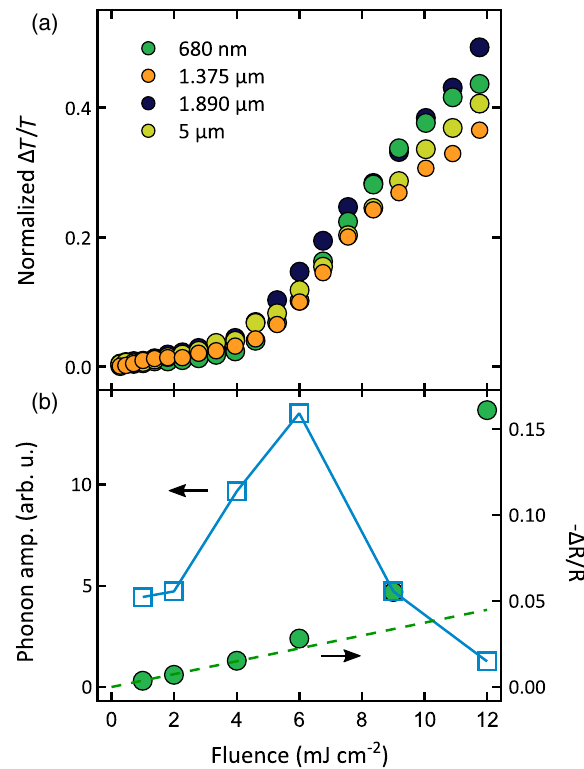
FIG. 5. (a) Normalized change in transmissivity of a free- standing VO 2 sample at 1-ps time delay measured at 100 Hz in air for different probe wavelengths. Below- and above-gap probing show the same threshold fluence, indicating that both the electronic and structural transitions occur at the same critical fluence. (b) Coherent phonon amplitude as a function of fluence measured at 690 nm from a single-crystal sample, compared with the reflectivity change measured at 1 ps, indicating the threshold measured in the visible spectral range corresponds to the structural threshold. The dashed green line is a linear fit to the low-fluence